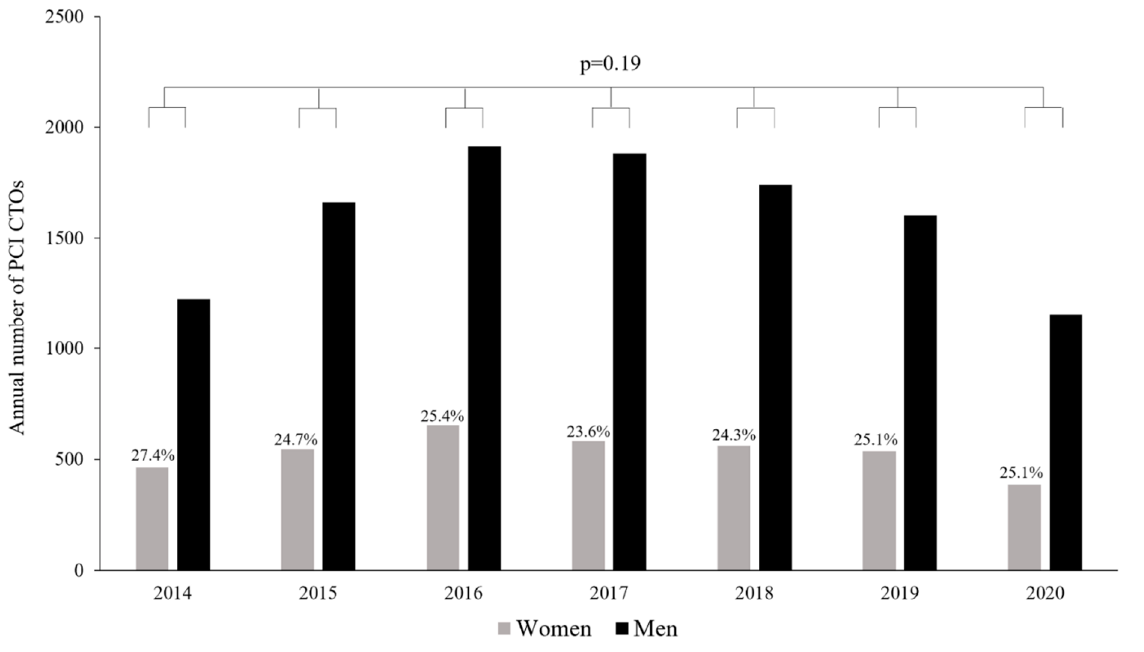
Figure 1. Percentage share of women and men in following years covered in the presented analysis.